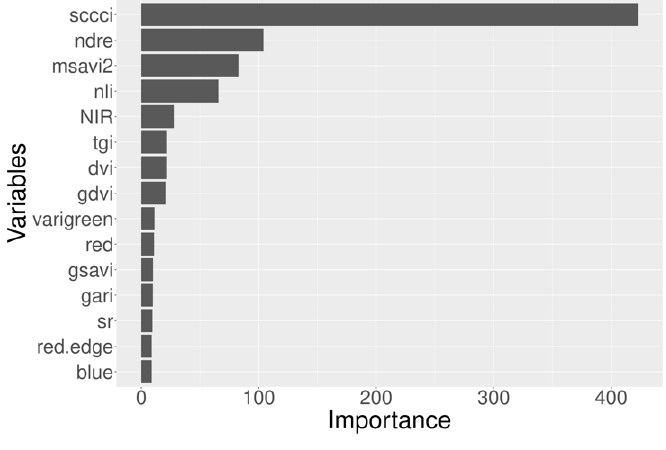
Figure 9. The linear model selection at the VT stage.